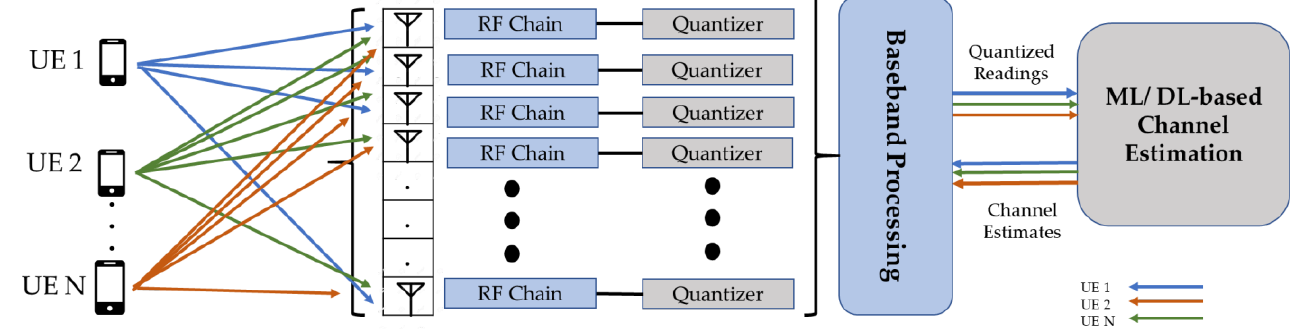
Figure 1. DL/ML-based M-MIMO system.